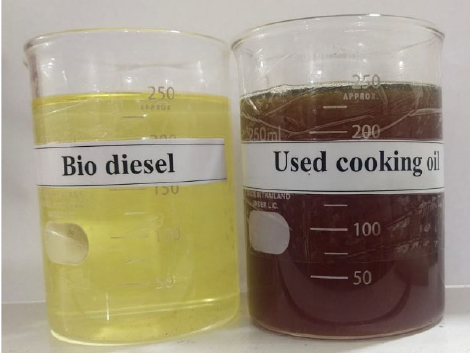
Figure 1. Waste cooking oil and distilled biodiesel. For the transesterification process, the methanol-to-oil molar ratio of 6:1 was used with potassium hydroxide (KOH) as catalyst. At the first stage, 6 L of methanol was mixed with 20 g of KOH at an elevated temperature. Subsequently, the pre-treated WCO was added with continuous stirring for 2 h at 60 ◦ C. The chemical reaction of the transesterification process is shown in Figure